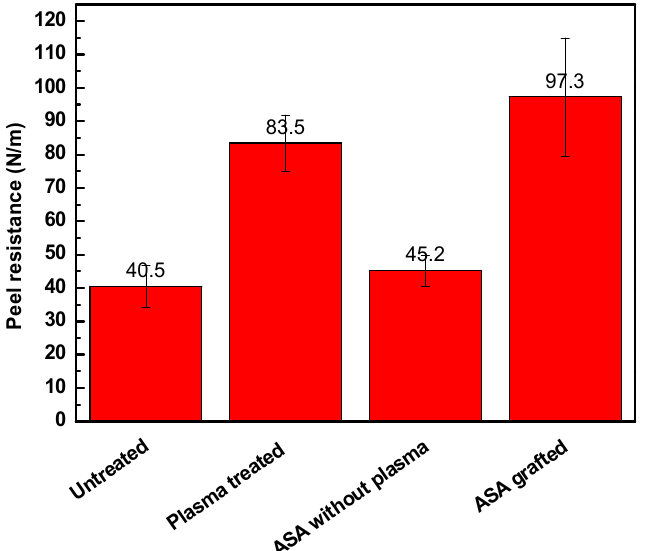
Figure 5. Peel resistance of LDPE samples.